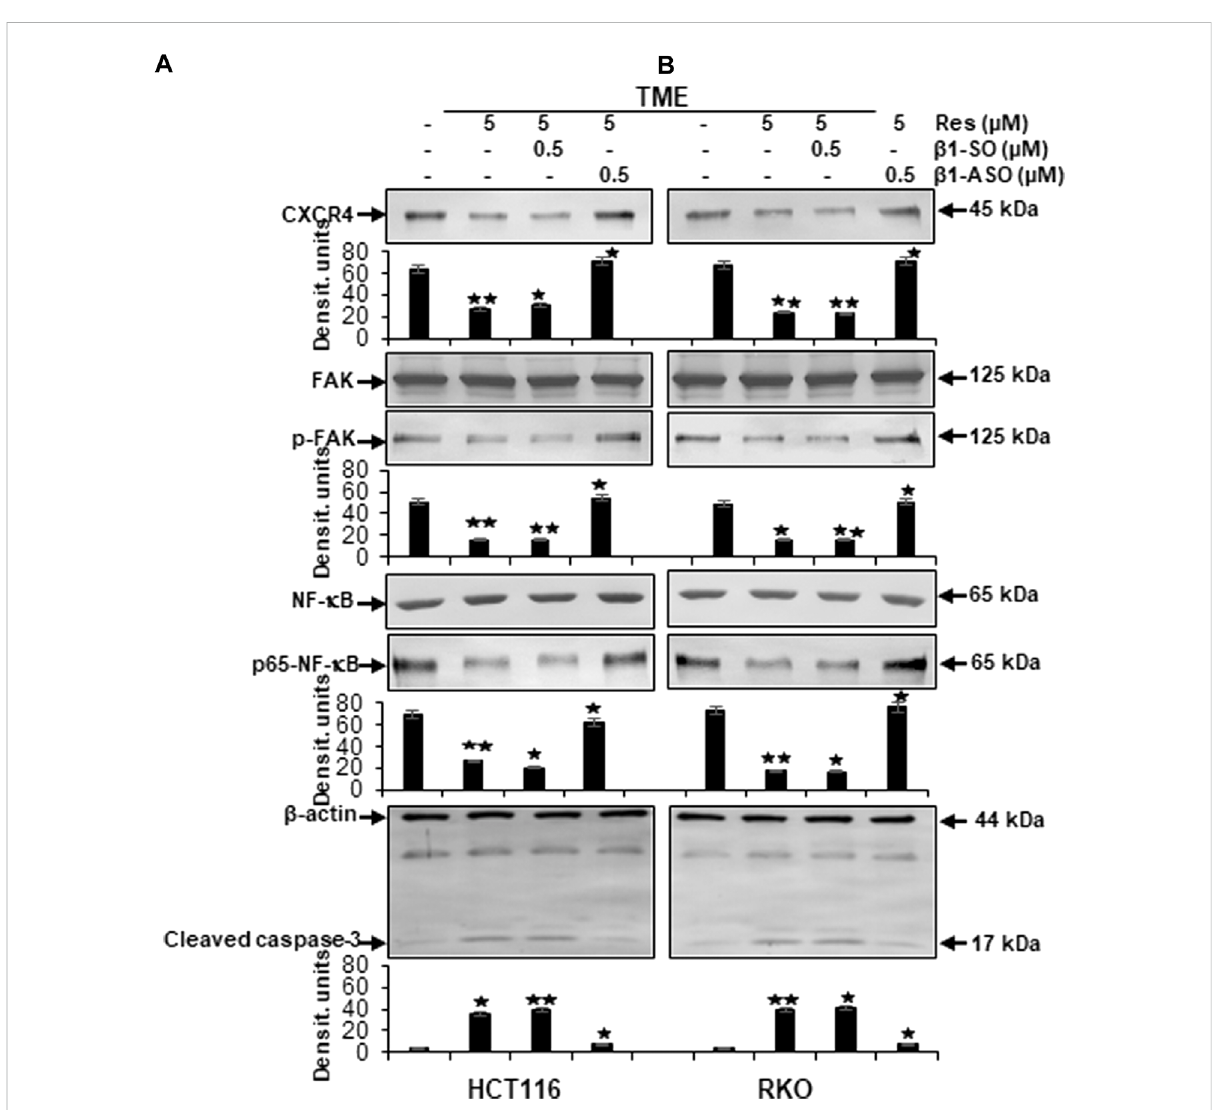
FIGURE 6 Impact of resveratrol or/and ASO against β 1-integrin on TME-promoted activation of metastasis and apoptosis parameters in CRC cells. HCT116 (A) and RKO (B) derived from 3D-alginate cultures were grown untreated or treated with 5 µM resveratrol alone or in combination with 0.5 µM β 1-SOor0.5 µM β 1-ASO( x -axis)andprobedwithantibodiesagainstCXCR4,FAK,p-FAK, NF- κ B,p65-NF- κ Bandcleaved caspase-3.Loading control: β -actin. Densitometric units complementing Western blot results ( y -axis). For densitometric analysis, data were compared to TME control: * p < 0.05 and ** p <